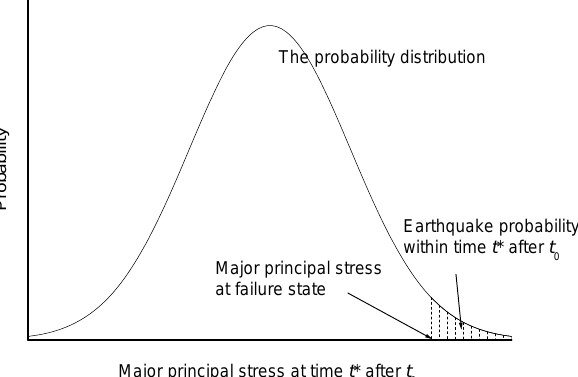
Figure 7. The essentials of the new non-stationary model: develop- ing the probability distribution of the major principal stress at time Fig. 7. The essentials of the new non-stationary model: Developing the probability t ∗ (i.e., σ 1_ t ∗ ) after the last event or after t 0 distribution of the major principal stress at time t * (i.e., 1_ * t 